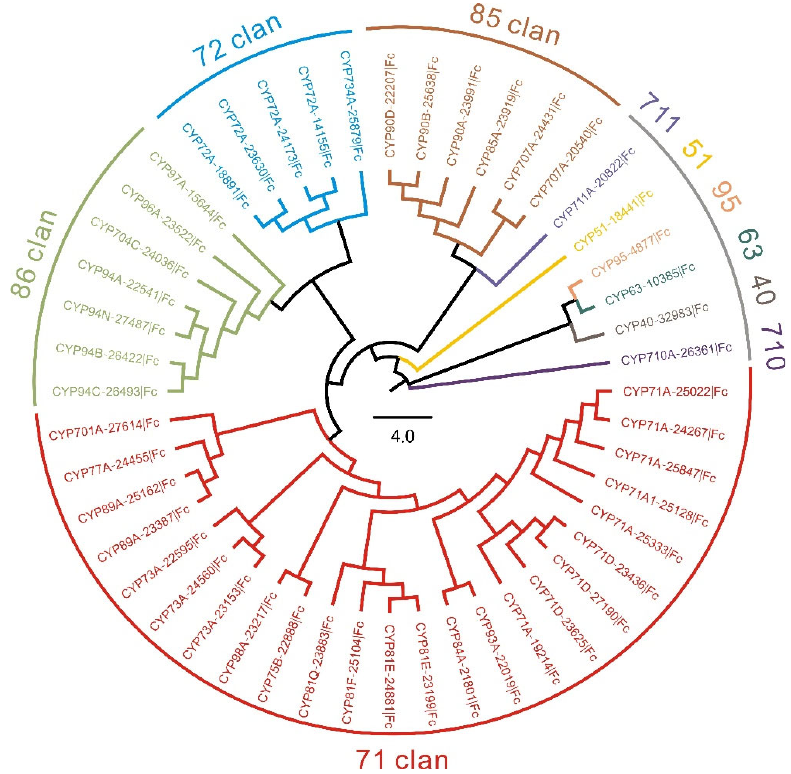
Figure 1. Phylogenetic analysis of predicted CYP450s in F. cirrhosa.